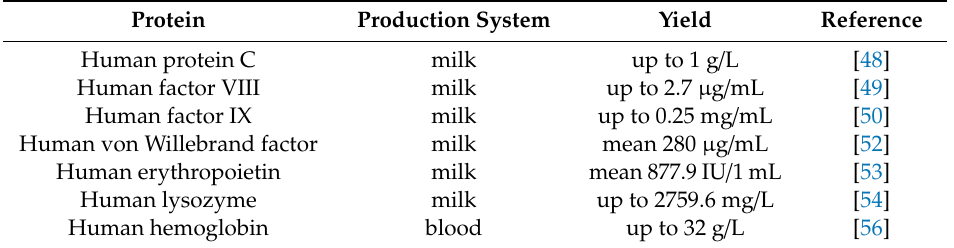
Table 3. Recombinant proteins produced from transgenic pigs for pharmaceutical use.